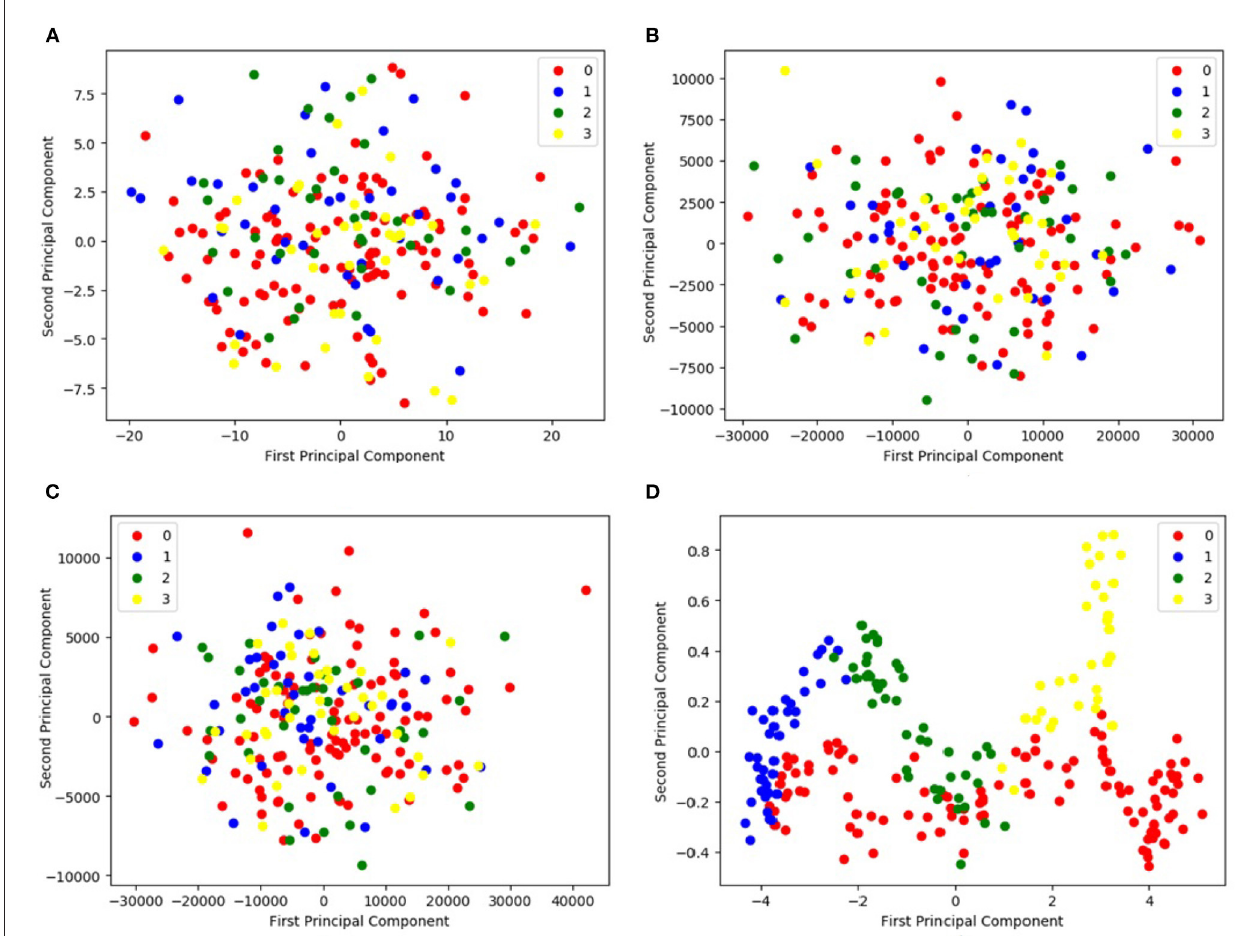
FIGURE 5 | Representation of feature distribution on CNP dataset. (A,B) Visualize the fMRI and sMRI feature matrices processed by PCA, respectively. (C) Visualizes the combined feature matrix for the fMRI and sMRI images processed by PCA. (D) Visualizes the feature matrix produced by DCL. In the legend, 0 represents HC, 1 represents SZ, 2 represents BD, and 3 represents